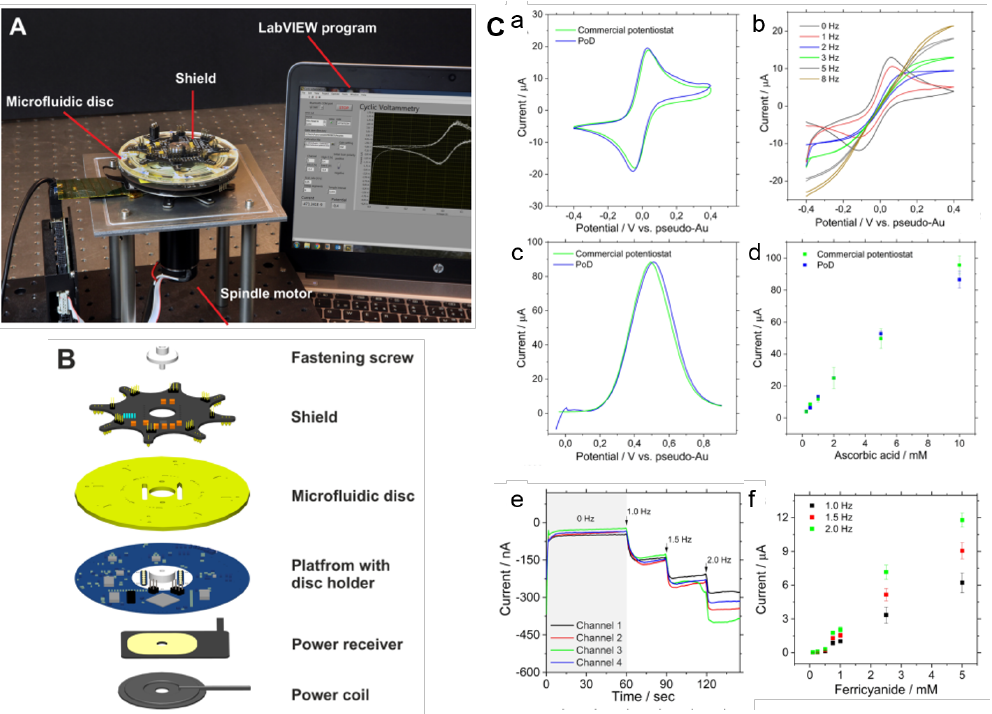
Figure 12. ( A ) Photograph of the experimental set-up with the spindle motor, LoaD platform, PoD and computer to control the software interface. ( B ) Exploded view of the PoD and LoaD device. ( C ) PoD results: ( a ) CVs of 1 mM FiC (Au working electrode with area of 50 mm 2 , scan rate of 50 mV/s comparing PoD and commercial potentiostat results, and ( b ) CVs collected in various rotation speeds at scan-rate of 100 mV/s; ( c ) SWVs of 10 mM ascorbic acid (carbon working electrode with 50 mm 2 , potential step 0.004 V, frequency of 10 Hz and amplitude of 0.025 V), and ( d ) calibration curve for ascorbic acid concentrations. ( e ) Amperometric response for 500 µM FiC (pH 7.4 PBS as supporting electrolyte, applied potential of − 0.4 V vs pseudo-Au reference electrode; working electrode area: 0.69 mm 2 ; Au counter-electrode) in different rotation speeds, and ( f ) the normalised current changes recorded for different FiC concentrations during rotation at 1.0, 1.5, and 2.0 Hz ( n = 3). Adapted with permission from [153]. Copyright 2019 American Chemical